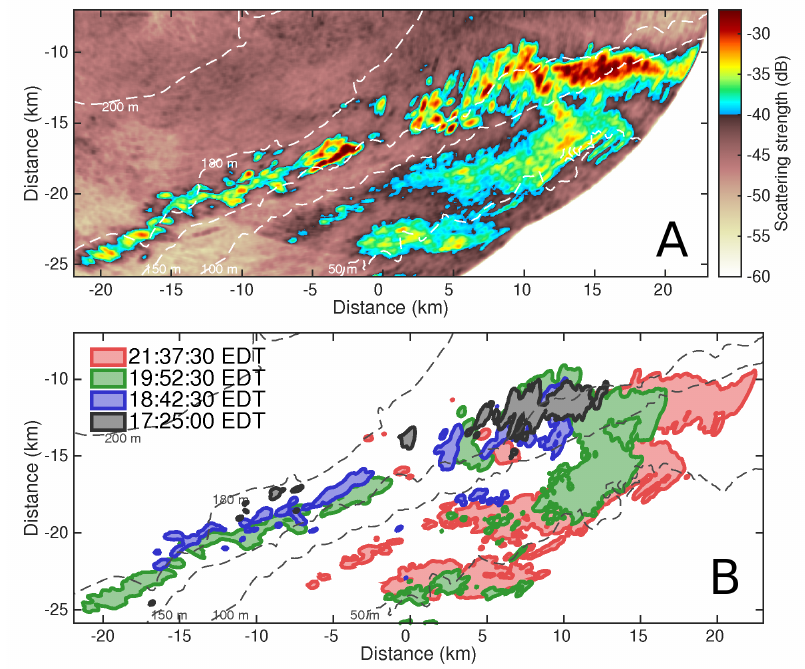
Figure 3. ( A ) highest measured scattering strength for each spatial position on the northern flank of Georges Bank during shoal formation and subsequent migration towards spawning grounds monitored from 17:25:00 to 21:37:30 EDT on 29 September 2006. Herring begin the shoal formation process at locations with seafloor depth of roughly 140 m to 180 m at 17:25:00 EDT, further develop along the bathymetric contour and into the shallower waters, and then stay mostly at locations shallower than 140 m at 21:37:30